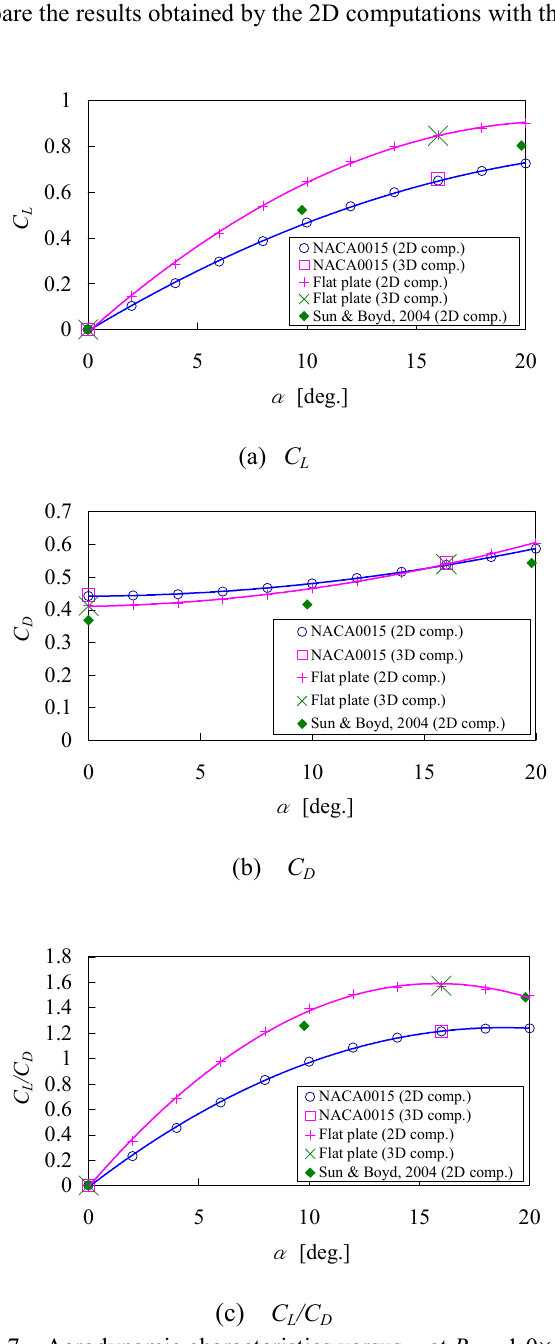
Fig. 7 Aerodynamic characteristics versus α at Re = 1.0×10 2 (NACA0015 and flat